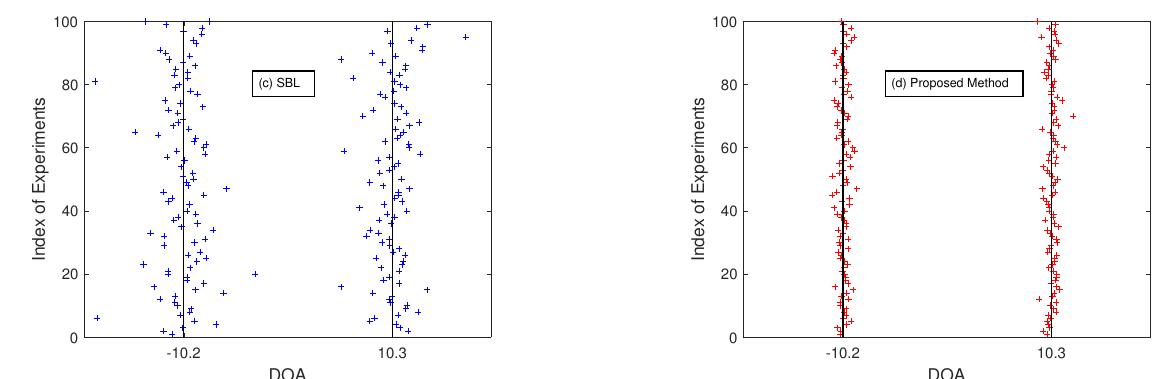
Figure 4. Performance comparison of the algorithms for coherent signals. ( a ) FISTA. ( b ) l p -MUSIC. ( c ) SBL. ( d ) Proposed method. The vertical lines denote the true DOAs, and the plus signs denote the DOA estimates in the